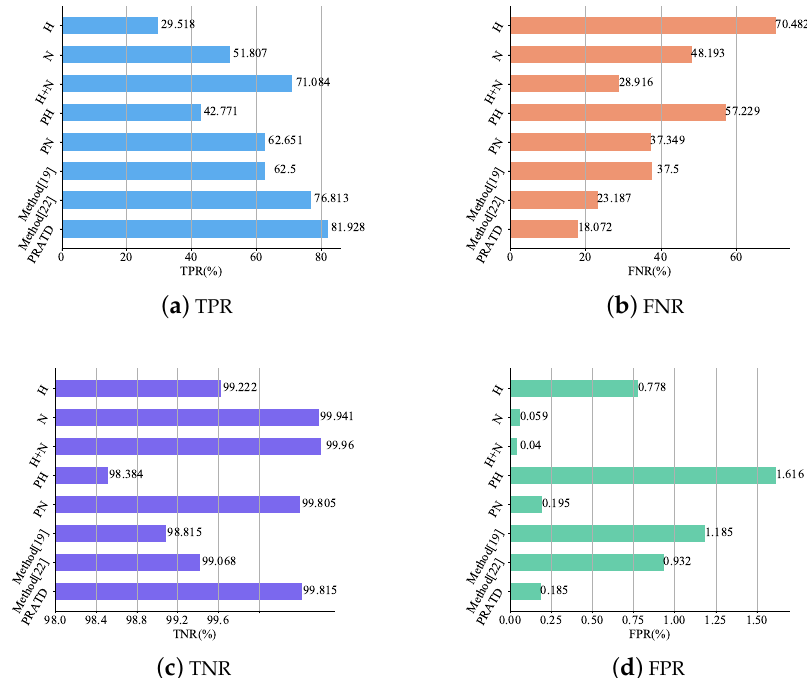
Figure 6. The detection results obtained by the different methods on the unknown test set.